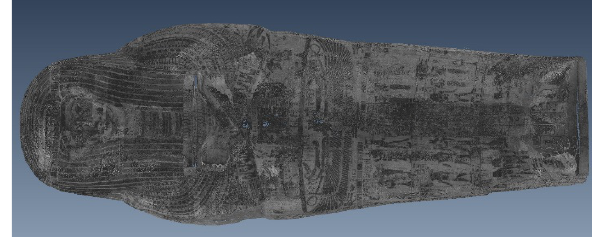
Figure 8. The mesh model.